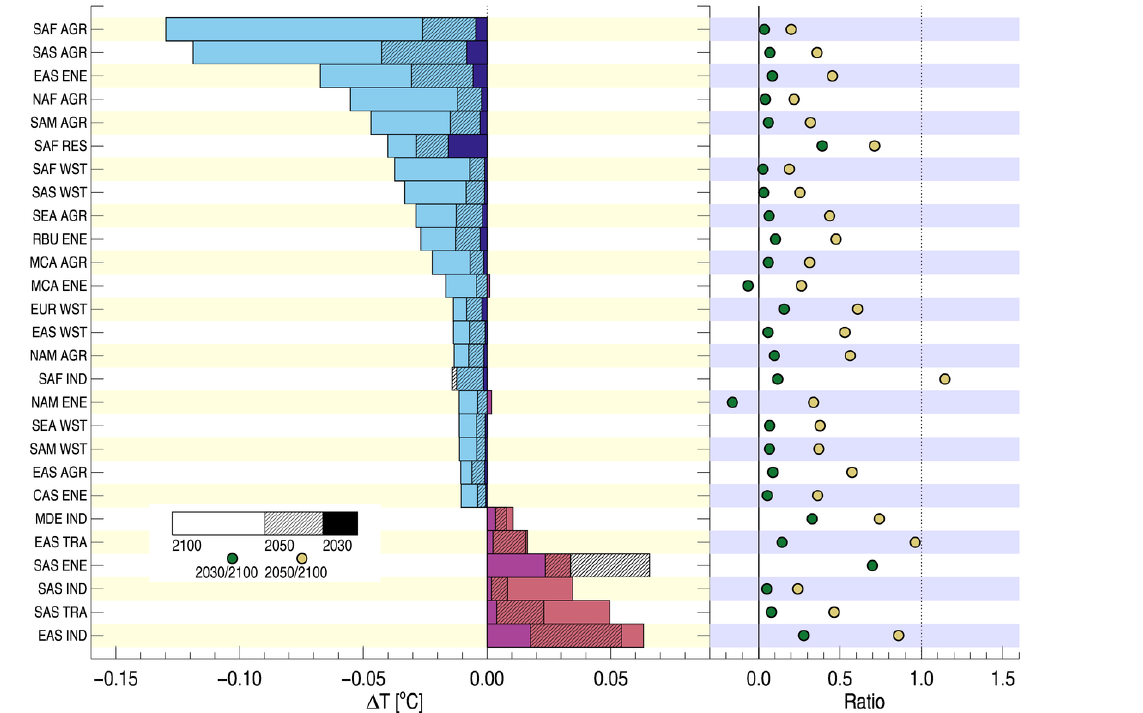
Figure 5. Difference in net SLCF (i.e., sum of all components except CO 2 ) temperature response between SSP1-1.9 and SSP3-7.0 in 2030, 2050, and 2100 by region and sector. Only combinations of sectors and regions where the differences in global temperature response is larger than ± 0 . 01 ◦ C are shown. For each of these combinations, the data on the right show the ratio between the temperature response difference in 2030 and 2100 and between 2050 and